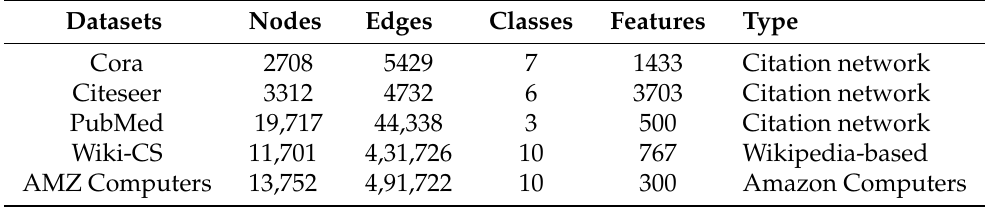
Table 1. Datasets description.